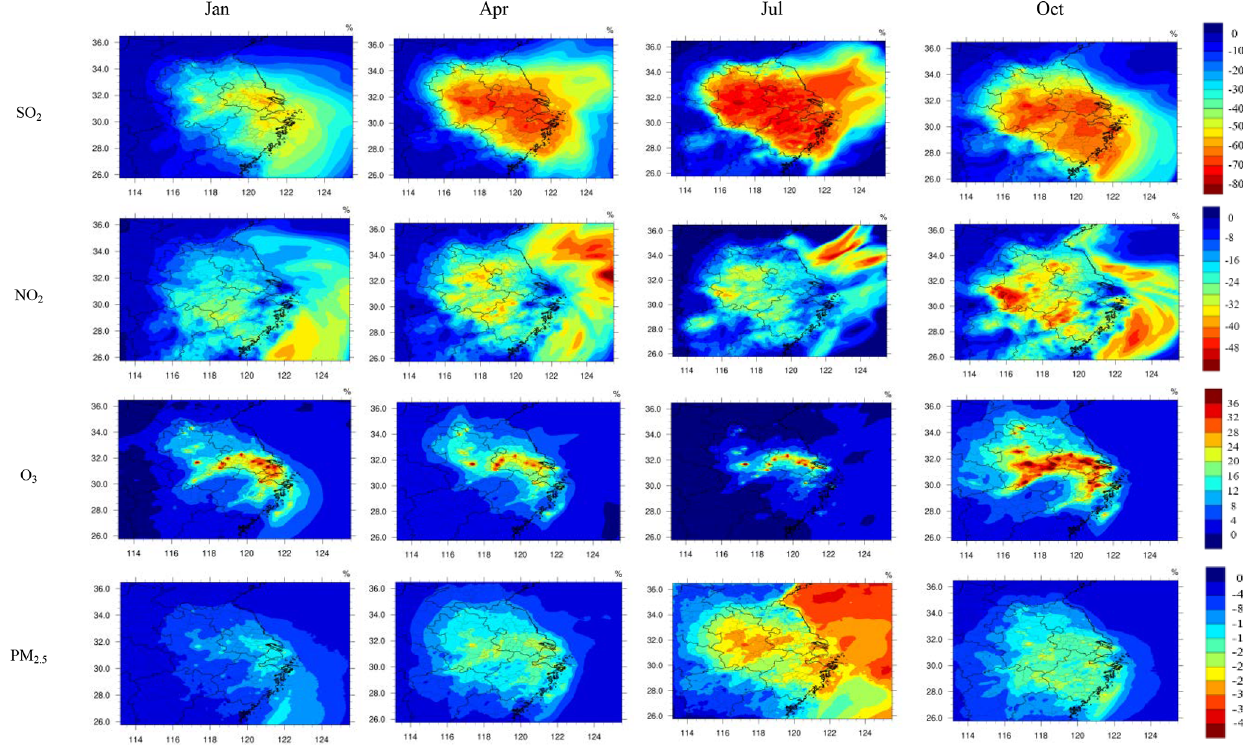
Figure 4. The spatial distributions of the relative changes (%) in the simulated monthly SO 2 , NO 2 , O 3 , and PM 2 . 5 concentrations between cases 2 and 4 in D2 ((case 4 − case 2) / case